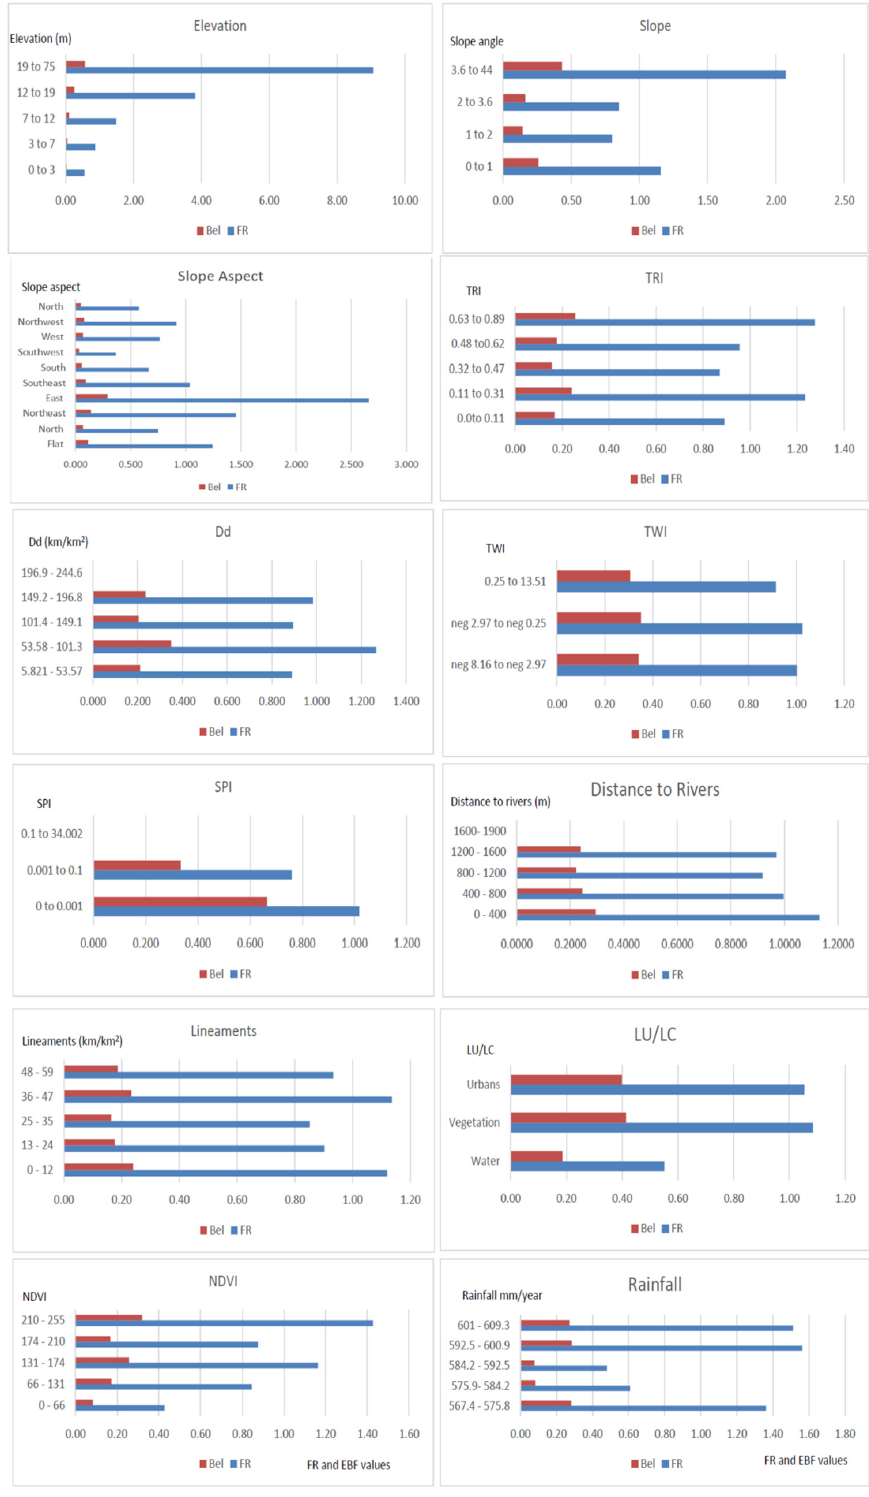
Figure 6. Variations in computed classes in FR and EBF models.